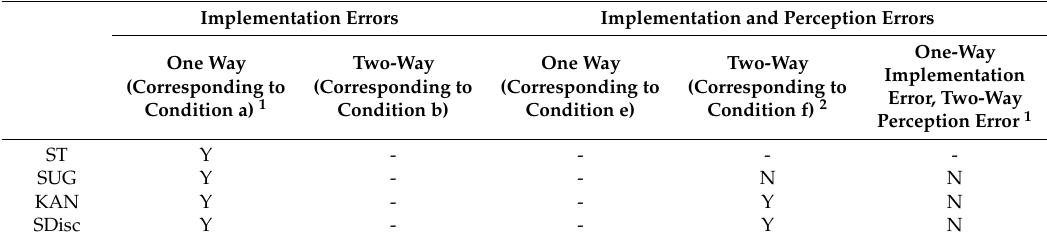
Table 4. Which norms are evolutionary stable in the